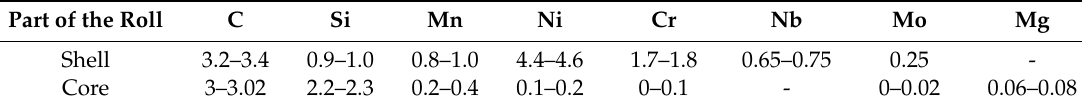
Table 1. Chemical composition range of the shell and the core